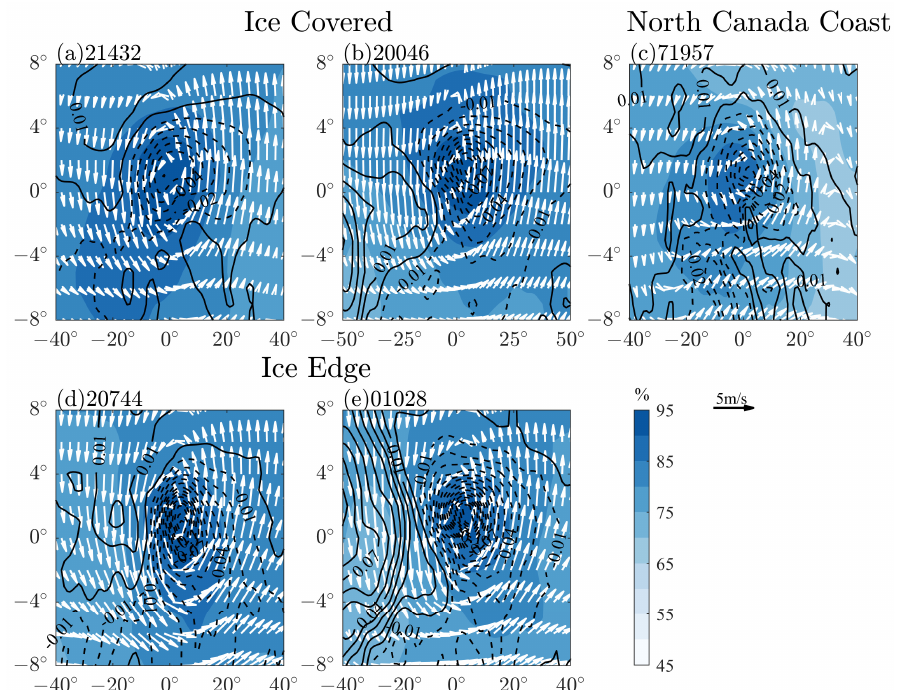
Figure 8. Cyclone-centered composites of horizontal velocity vectors (white vectors), vertical velocity (black contours, the positive and negative values for the sinking and rising, respectively, unite, Pa/s), and relative humidity (blue shaded) at 850 hPa level based on all cyclone days on which the cyclone centers are located within the distance of nearly 800 km from the location of each sounding station during autumns for the period 2001–2017. In the composite, a relative coordinate is used, with the coordinate origin being the center point of the cyclones. The x axis ranges from 40 ° west to 40 ° east of the center point, and the y axis ranges from 8 ° south to 8 ° north of the center point. Generally, the composite horizontal cyclone circulation fi elds show that air rising/sinking is located in the region of southerly/northerly fl ow; the region of ascending/descending is consistent with the region of high/low relative humidity for all of the cyclone-centered composites at the fi ve stations (Figure 8) at the 850 hPa level where low cloud fraction is high (Figure 7) and cyclone-induced cloud uplift occurs (Figure 8). In contrast, at the station near the New Siberian Island (station 21432), air rising and high relative humidity are accompanied by northerly fl ow in the southwest of the cy- clone. This can be explained by the geography of the cyclone. Station 21432 is located on New Sibe- rian Island, close to Eurasia, where the cyclone’s southbound air fl ows from the cold East Siberian Mountains and its northbound air fl ows from the Arctic marginal sea. Station 71957 is located on the North American continent, and the in fl uence of the cyclone fl ow is weakened considerably. Therefore, the horizontal and vertical velocities in the cyclones at station 71957 and station 21432 are much smaller than the horizontal and vertical velocities in the cyclones at three stations in the Barents Sea, indicating a weaker lower troposphere intensity of the cyclones along the land coasts. Moreover, the relative humidity at 850 hPa is the smallest in the cyclones at the station of the north coast of Canada.